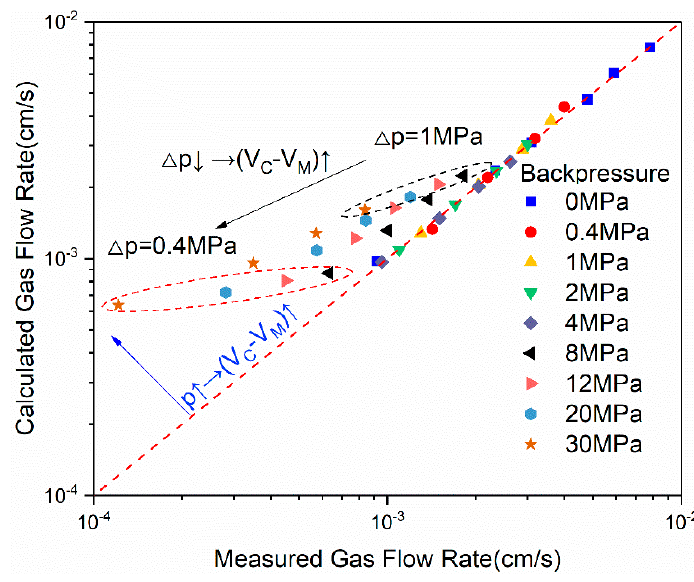
Figure 9. Measured flowrate versus theoretical flowrate at diverse backpressures for core Z2.